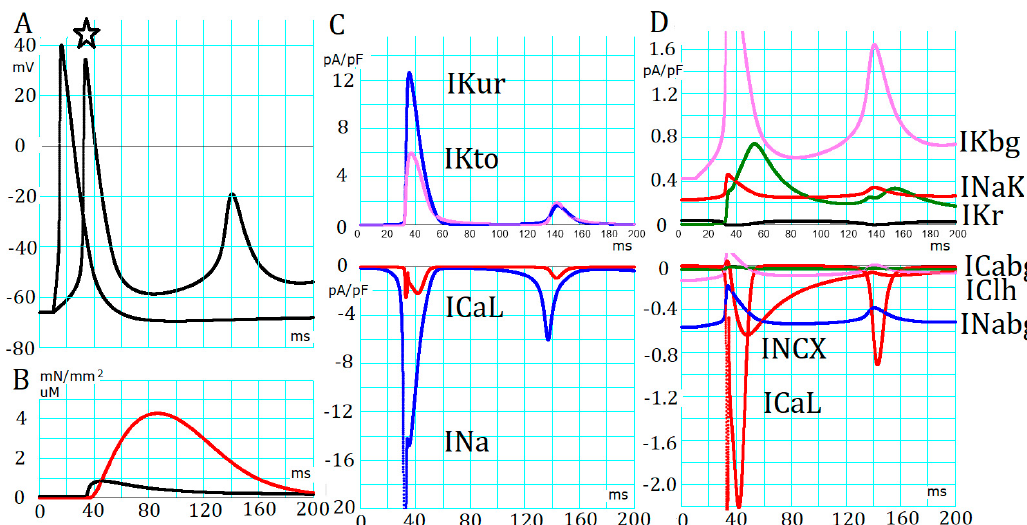
Figure 2. Membrane excitation in the absence of adrenergic (AR) stimulation: ( A ) Two records of action potential evoked by applying − 5 (3 ms in duration) or –0.5 pA / pF (180 ms) current pulses were superimposed. The star mark indicates an action potential (AP) evoked with a smaller pulse; ( B ) the Ca 2 + -transient (black, µ M) and the developed force of contraction (red, mN / mm 2 ); ( C , D ) membrane currents shown at a low gain and at a high gain, respectively. Outward and inward currents are shown in the upper and the lower panels, respectively. Resting potential = − 66.0 mV, [Na + ] cyt = 5.7 mM, [K + ] cyt = 117 mM, and [Ca 2 + ] SRrl = 0.71 mM.